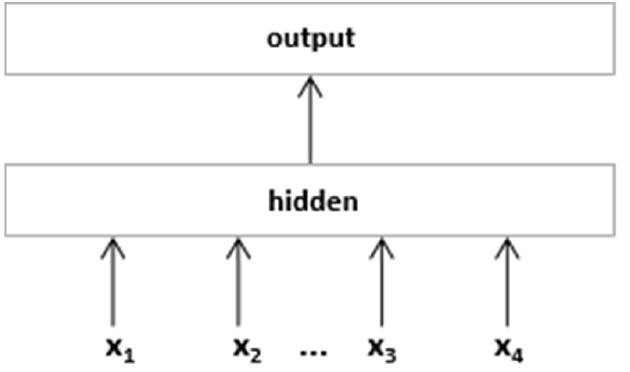
Figure 5. FastText model mechanism.